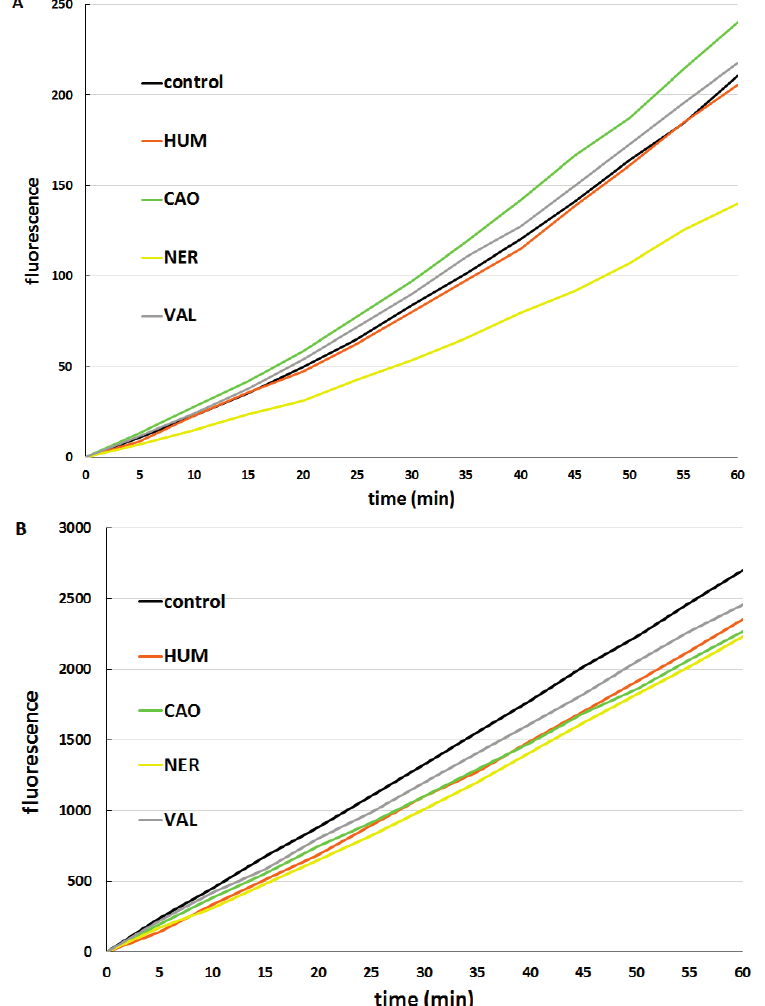
Figure 6. Effect of sesquiterpenes (10 µg/mL) on ROS formation in CaCo-2 cells ( A ); and hepatocytes ( B